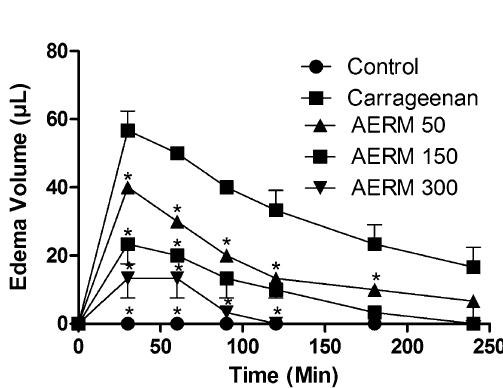
Fig. 5 Monitoration of paw edema induced by carrageenan. The analysis showed an inhibition when treatments were injected with AERM. Two-way ANOVA with Bonferroni as a post test ( p \ 0.01). Statistical differences relative to carrageenan (filled squares) are marked with *